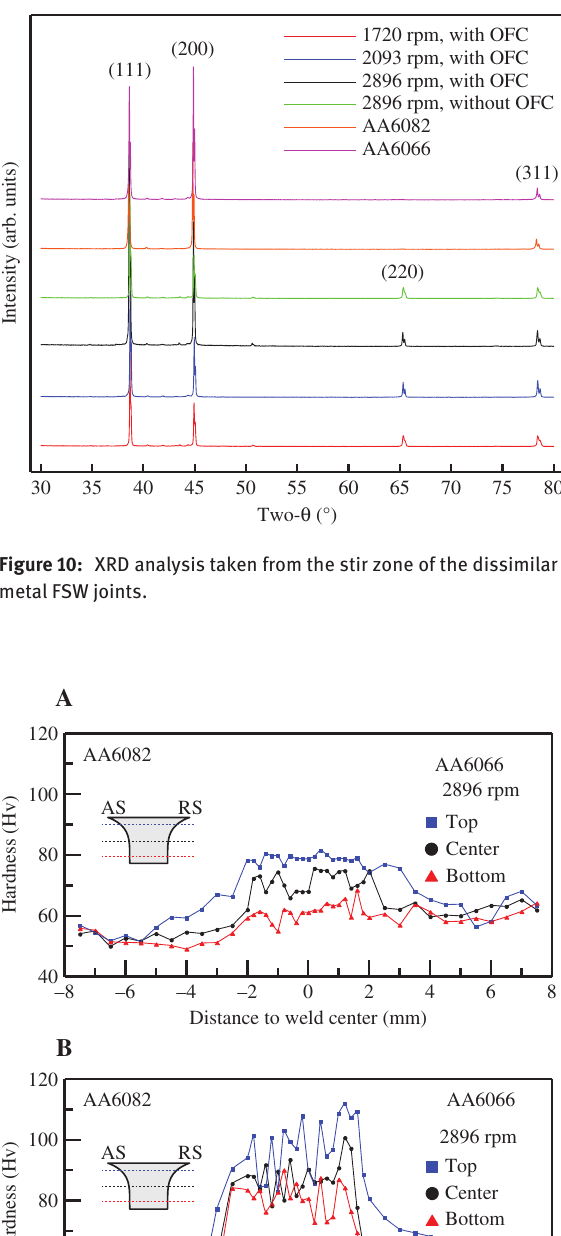
lower rotational speed (1720 rpm), the tensile strength of